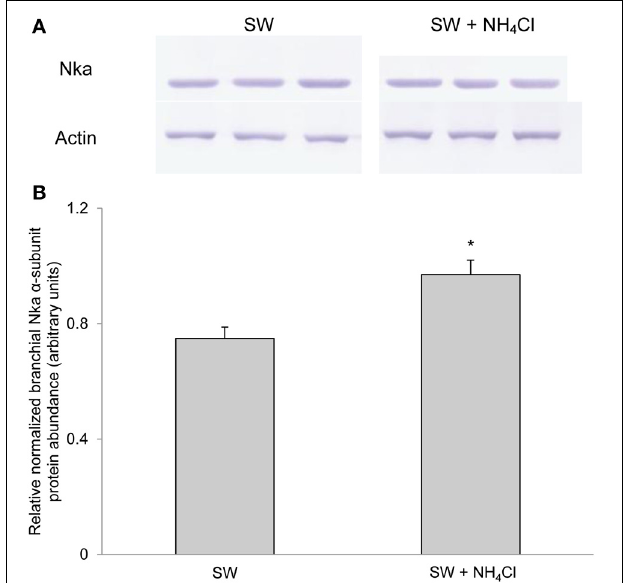
FIGURE 12 | Effects of exposure to ammonia in seawater on Na + /K + -ATPase (Nka) protein abundance. Protein abundance of Nka based on the α 5 anti-NKA antibody which is known to react with all Nka/NKA α -isoforms of gills of Periophthalmodon schlosseri after 6 days of transfer from slightly brackish water (SBW; salinity 3) to seawater (SW; salinity 30; control) or after 6 days of transfer from SBW to SW containing 50mmol l − 1 NH 4 Cl. (A) The immunoblots of Nka and actin. (B) The intensity of the Nka band was normalized with respect to that of actin. Results represent mean + s.e.m. ( N = 3). ∗ Significantly different from the control ( P < 0 .